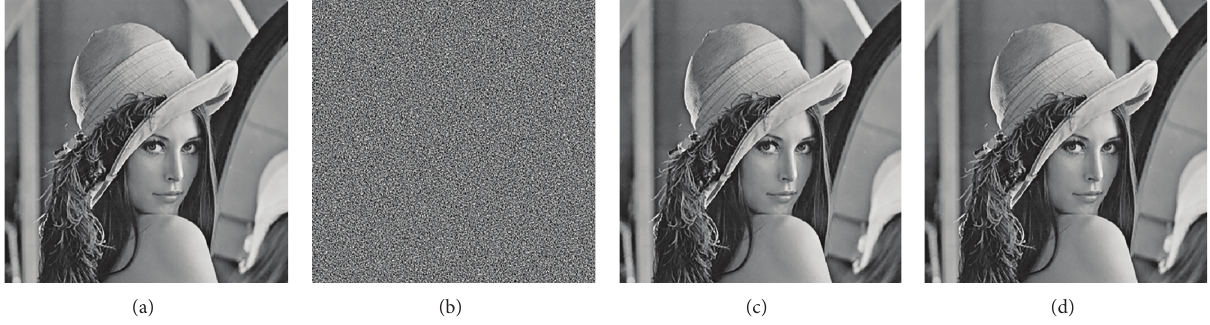
Figure 4: Images before and after